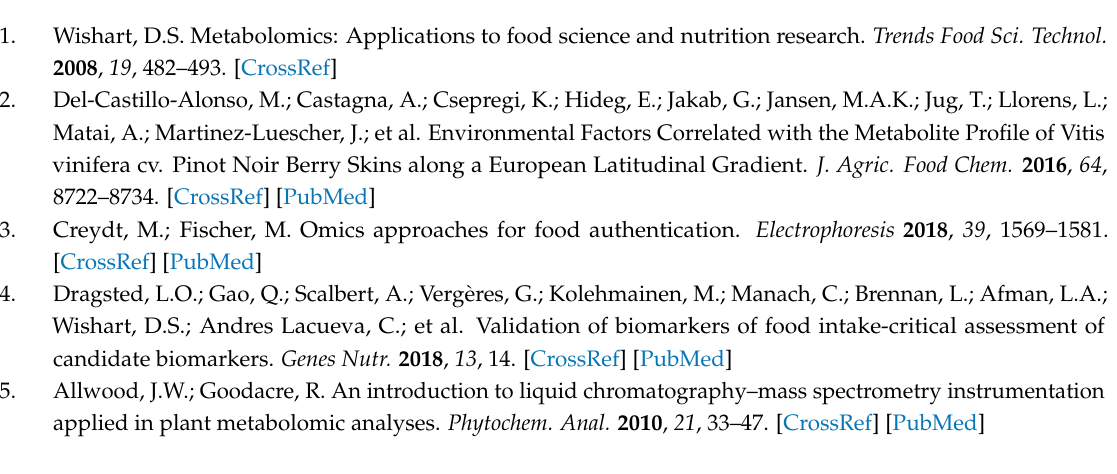
Figure S1: The contents of the standard operating procedure (SOP) sent to each participating platform, Table S1: A list of 181 plant bioactives and their metabolites selected as candidates for the multiplatform analysis classified based on their chemical or metabolite class, Table S2: Chemical standards analyzed in the multiplatform test. Author Contributions: Preparing the analytical mixtures, V.M.K. and A.B.d.S.; Drafting the manuscript,